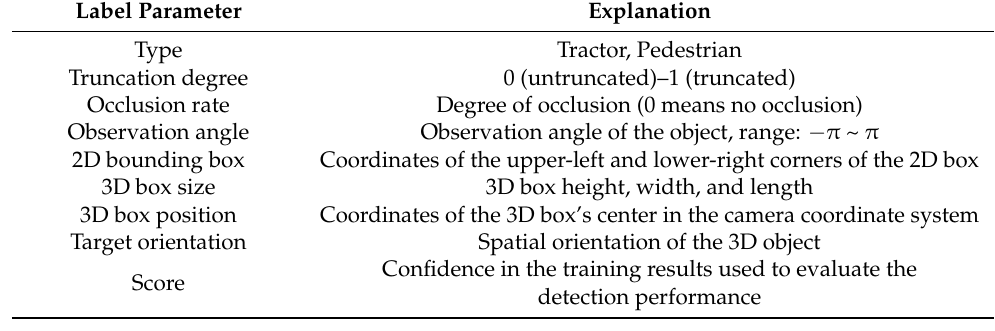
Table 1. Dataset label format.